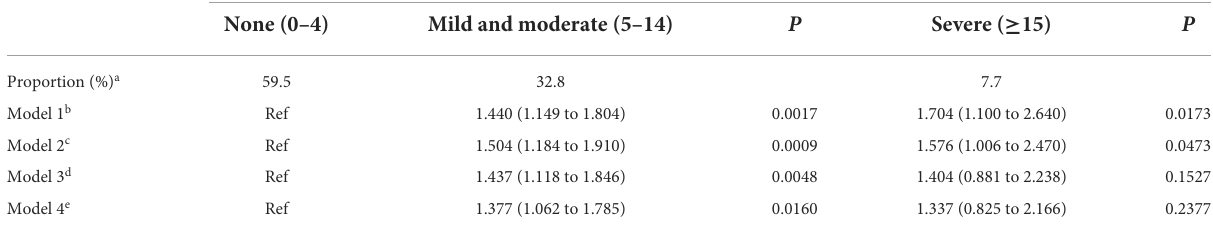
TABLE 2 Associations of depressive symptom severity and